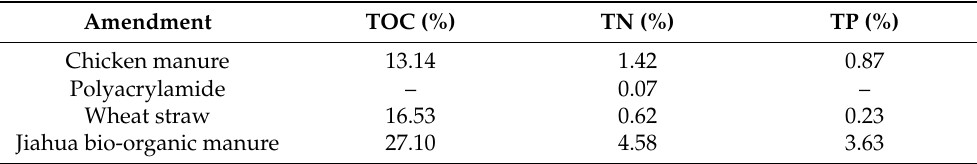
Table 3. Physicochemical properties of soil